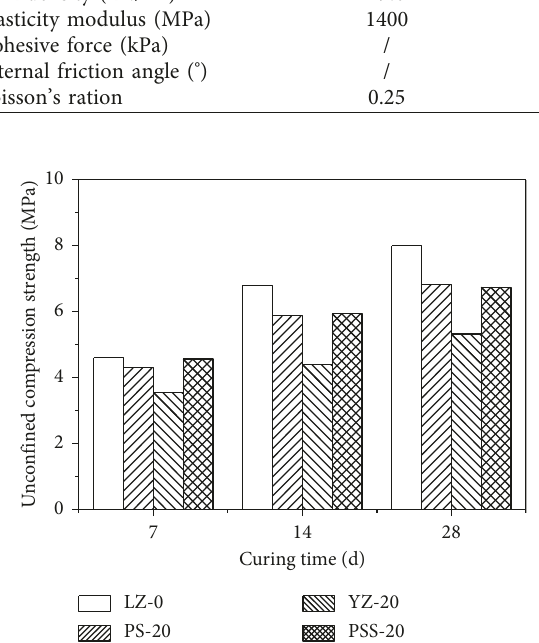
Figure 4: The unconfined compression strength of samples under different conditions (mixture ratio and curing time).